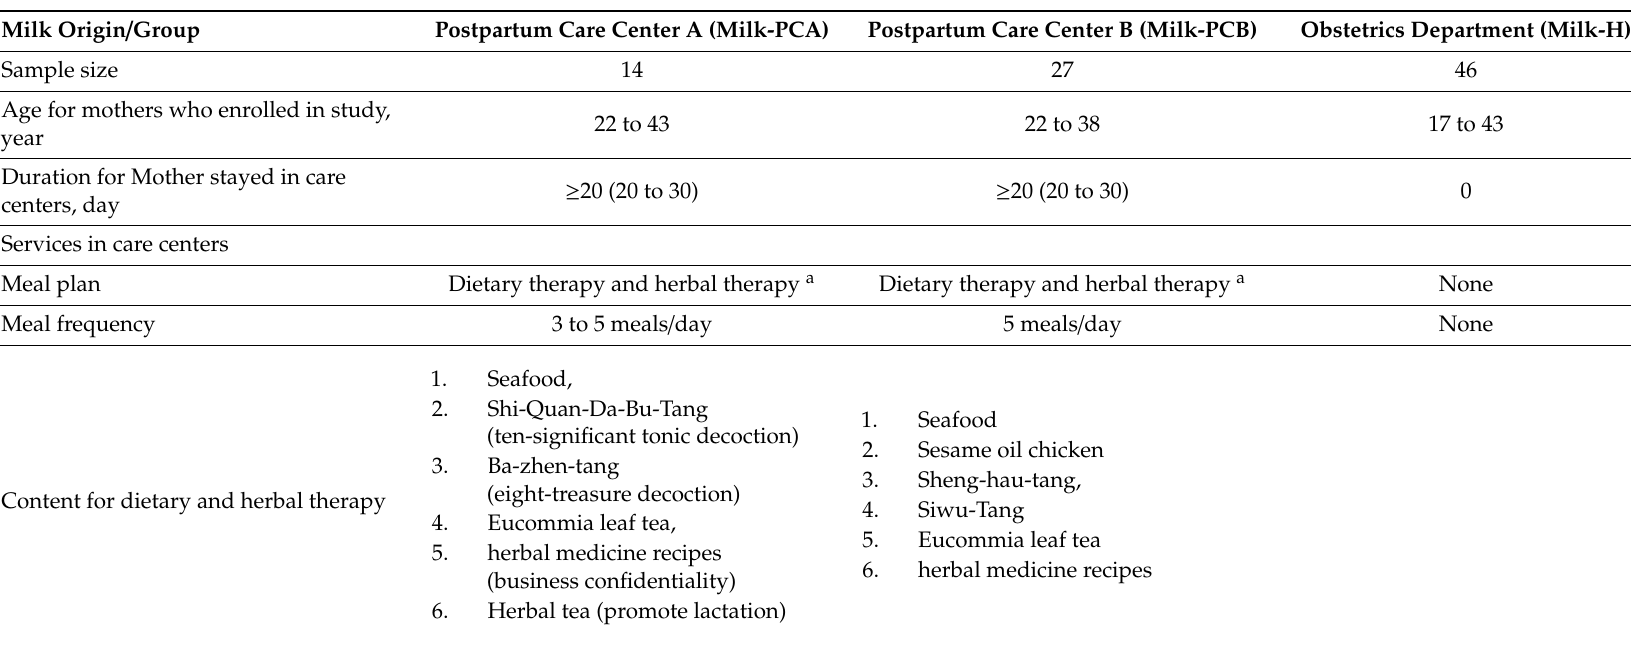
Table 1. Information for the “doing-the-month” and “non-doing-the-month” milk groups. Milk samples were collected from postpartum mothers who had completed the practice of “doing-the-month” (postpartum caring) for 20 to 30 days in postpartum care center A (milk-PCA, n = 14) or B (milk-PCB, n = 27). The control milk samples were harvested from the postpartum mothers in hospital who did not conduct the “doing the month” (milk-H, n =